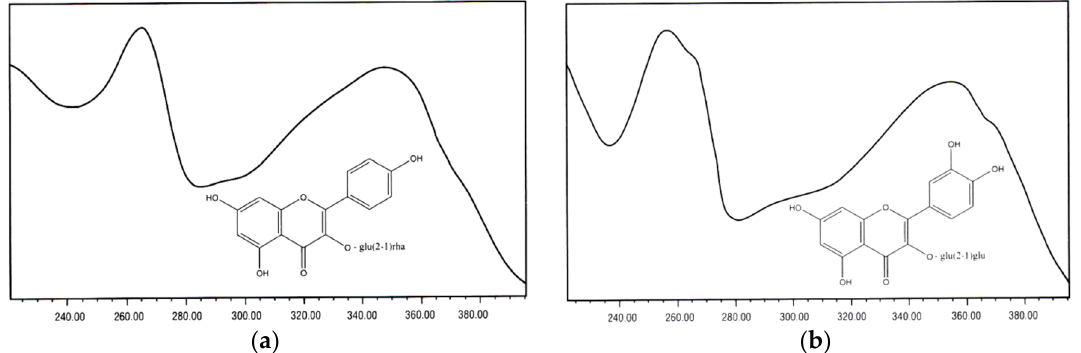
Figure 1. Examples of Flavonoid structures found in bee pollen (BP) and bee bread (BB), from [53] (with permission of the authors). Structure ( a ): Kaempferol-3- O- [rhamnosyl (1-2) glucoside] (RT (retention time) = 33.2; λ max = 265, 290 sh, 320 sh, 350 nm); ( b ): Quercetin-3- O- [glucosyl (1-2) glucoside] (RT = 30.6; λ max = 255, 266 sh, 294 sh, 355 nm).